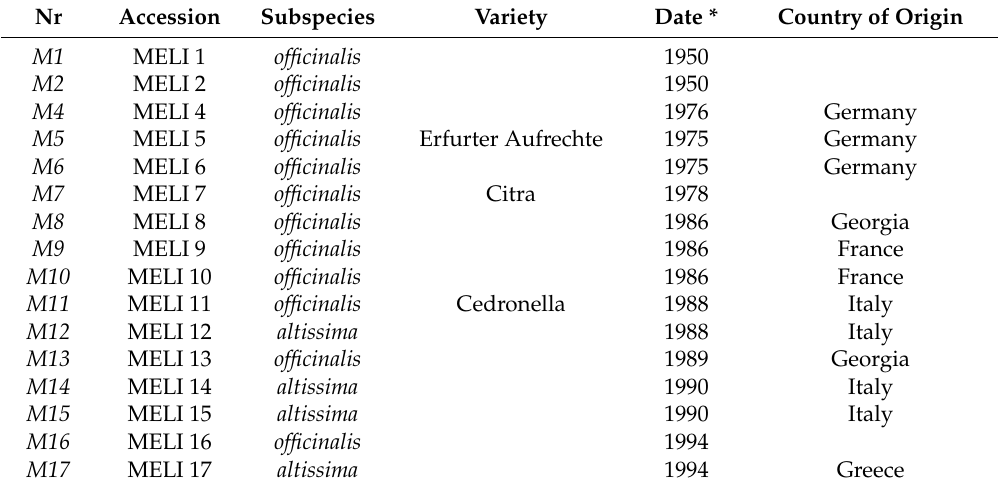
Table 4. List of Melissa officinalis accessions from